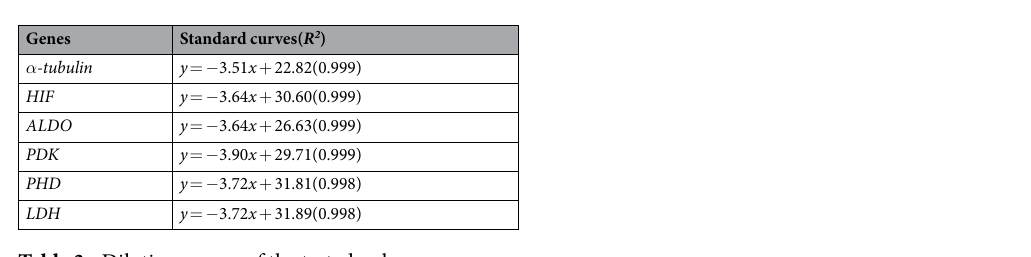
Table 3. Dilution curves of the tested polyp